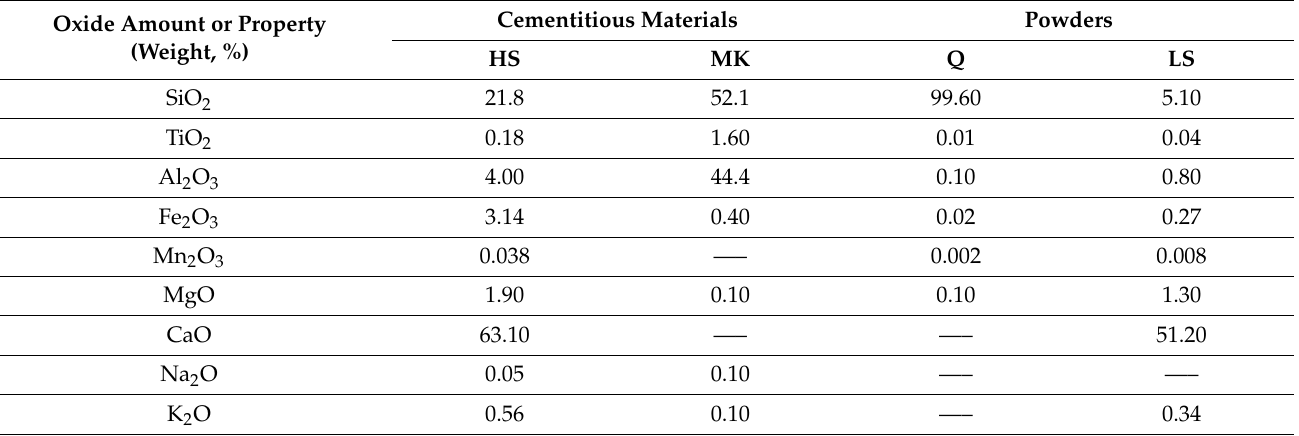
Figure 1. Particle size distribution of HS, MK, Q, L and the natural river sand. Table 1. Physical and chemical properties for HS, MK, Q and L, obtained by X-ray Table 2. Normalized chemical phase composition for HS, MK, Q and L.